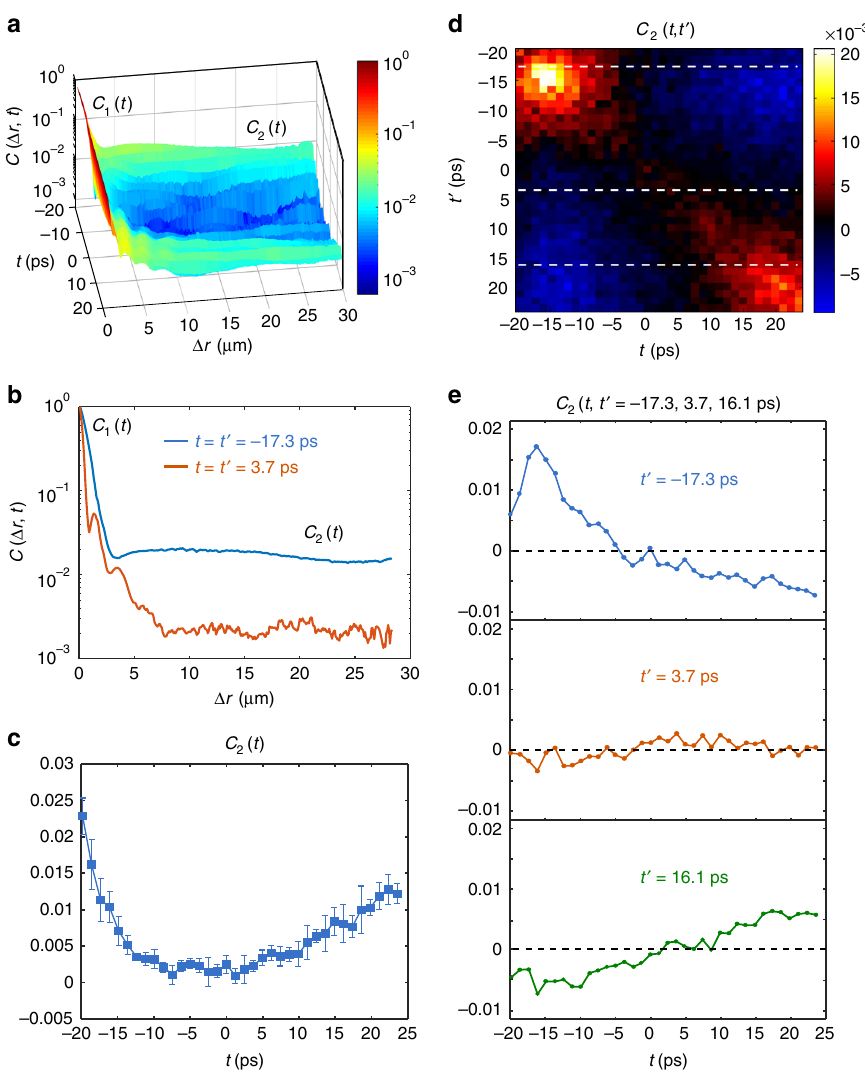
Fig. 2 Spatio-temporal correlations in MMF with strong random mode mixing. a Intensity correlations C ð Δ r ; t Þ (cid:4) C ðj Δ r j ; t ; t ′ ¼ t Þ , revealing a short-range component C 1 ( t ) ≈ 1 at spatial distance within one speckle ( Δ r ≲ 3 μ m) and a long-range component C 2 ( t ) that persists at large distance. b Two cross sections of C ( Δ r , t ) at arrival times t = − 17.3 ps and t = 3.7 ps. c Time dependence of the long-range component C 2 ( t ), averaging over Δ r for Δ r > 5 μ m. The error bars represent the standard deviation among four measurements of the fi ber in different bending con fi gurations. d Long-range correlations C 2 ( t , t ′ ) between spatio-temporal speckle grains at different arrival times t and t ′ . e Cross sections of C 2 ( t , t ′ ) at t ′ = − 17.3 ps, 3.7 ps and 16.1 ps (marked by white dashed lines in d